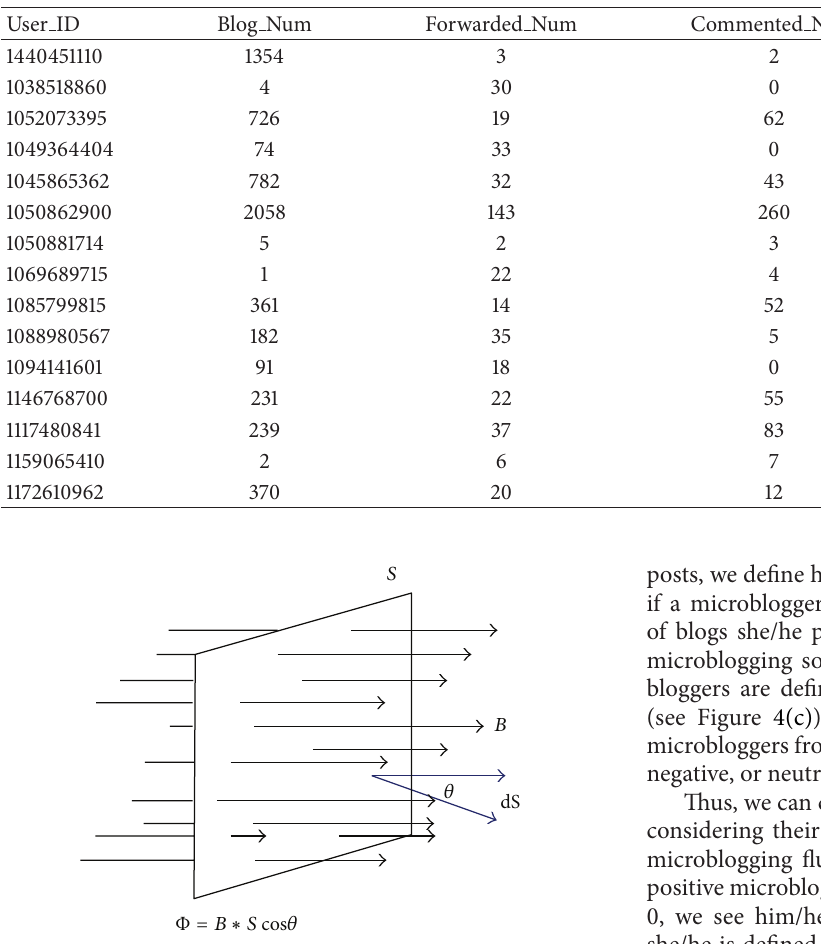
Table 1: The parameters of microbloggers.